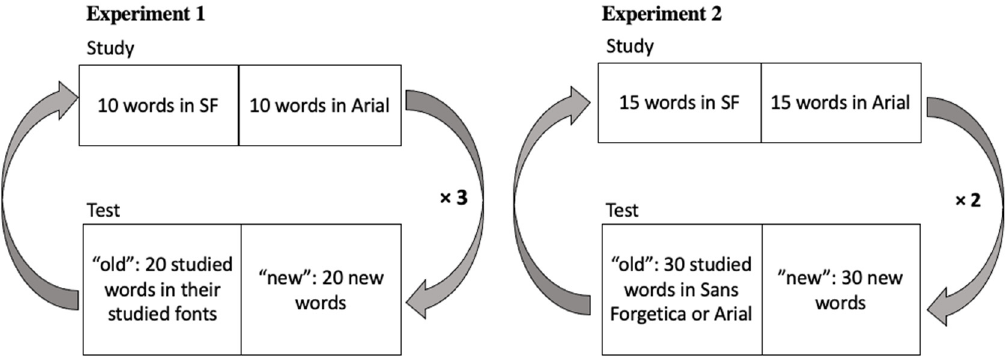
Figure 3. Experimental timeline for Experiment 1 ( left ; 3 blocks) and Experiment 2 ( right ; 2 blocks).